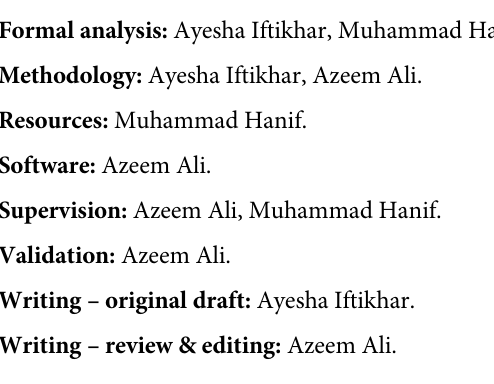
S4 Appendix. Table 9: Mean, average bias, standard error and MSE for different